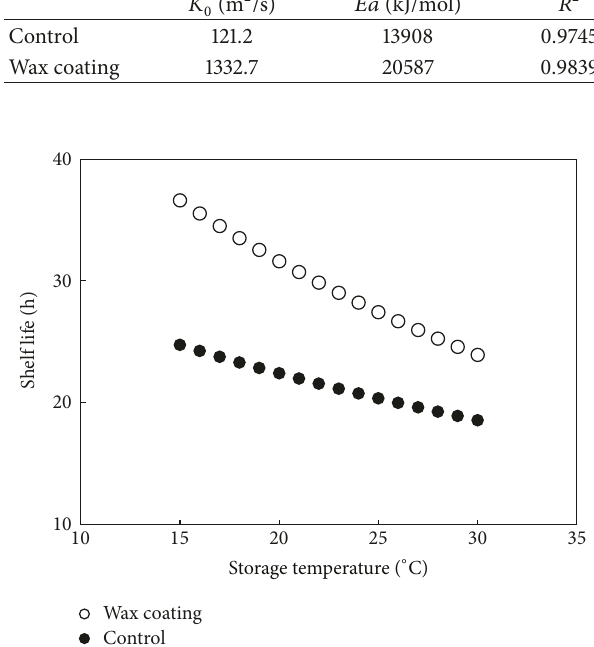
Figure 3: Shelf life of cucumbers at different storage temperatures, but all with 55% relative